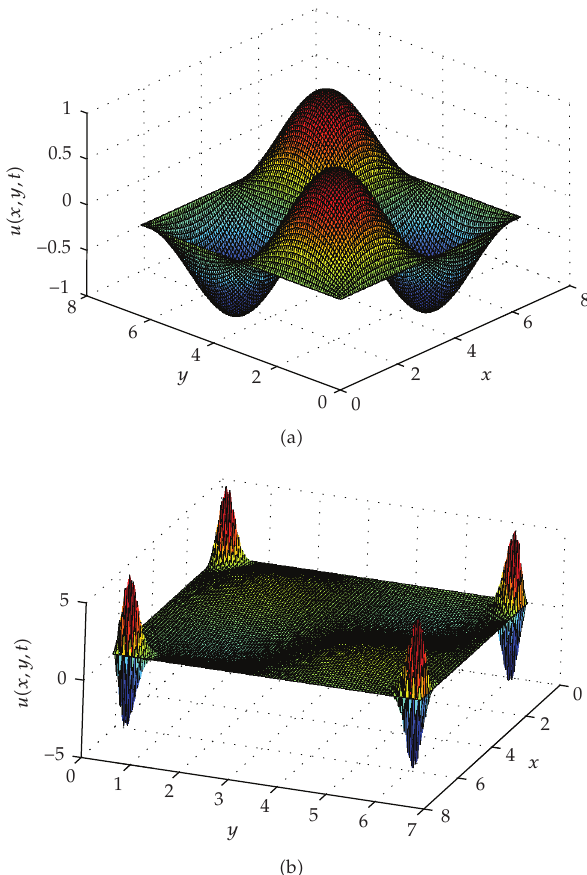
Figure 3: The numerical results in (cid:6) a (cid:7) at t (cid:5) 0 and in (cid:6) b (cid:7) at t (cid:5) 0 . 046 when f (cid:6) · ,u (cid:7) (cid:5) u 2